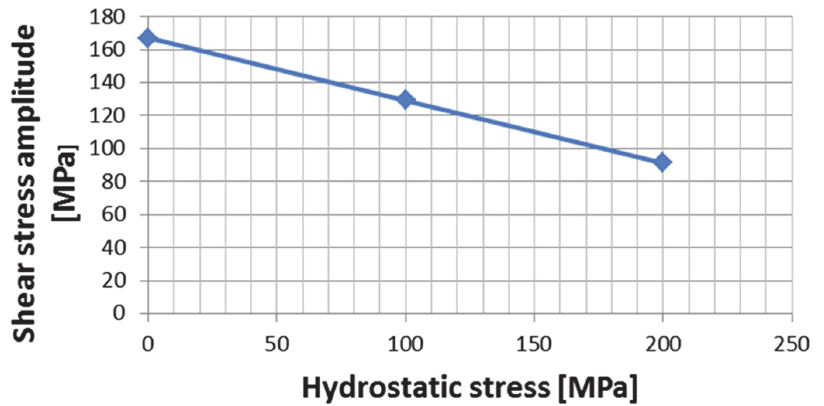
Figure 2: The Dang Van design line for the fatigue limit at N=10 7 cycles.